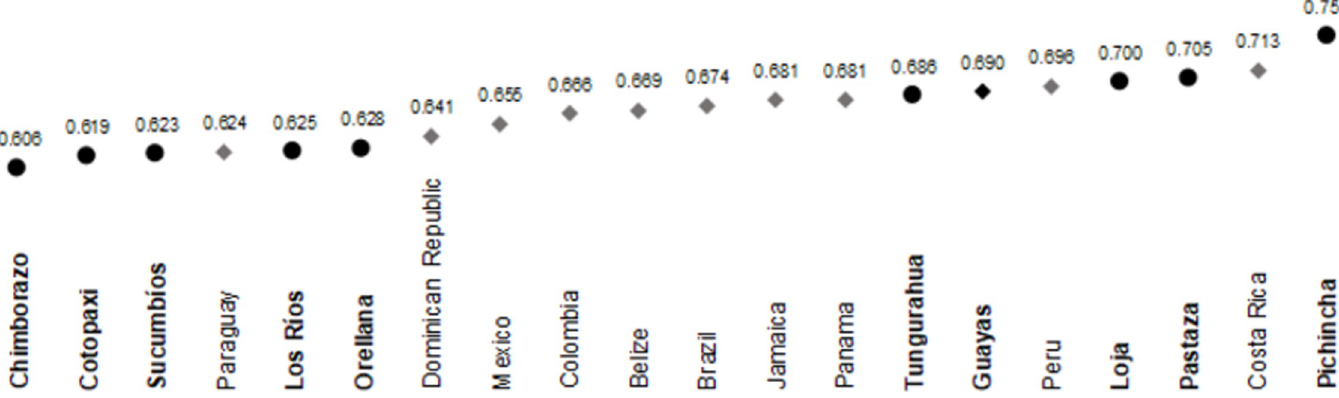
Fig 5. Comparison between the values of the Provincial-level Education Index of the provinces with the highest and lowest value of said index and the values of the education index of the Human Development Index for countries with an upper-middle income in Latin-America and the Caribbean. 2014. Note: Upper-middle income countries in 2014 are those with a gross national income per capita of between $4,126 and $12,735 according to the World Bank classification in 2014 [99].